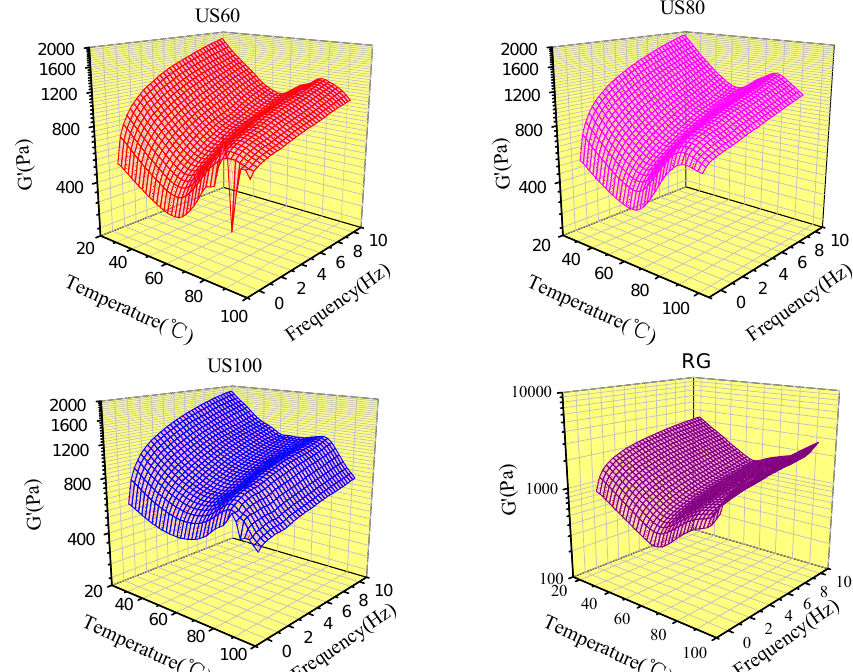
Figure 5. Storage module of ultrasound treated gluten samples as a function of temperature and frequency.